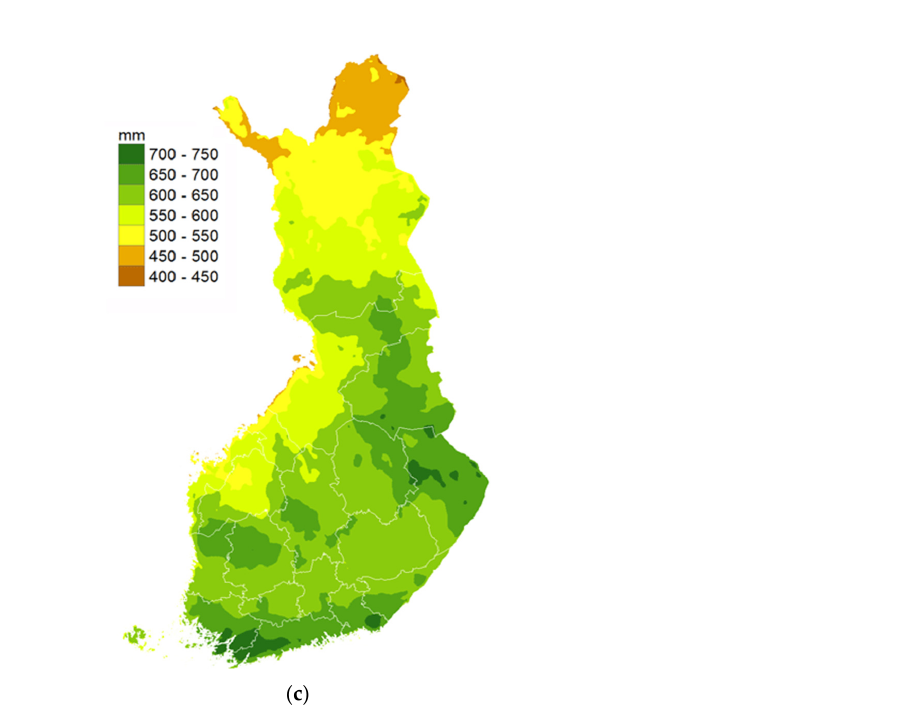
Figure 1. ( a ) Study area and FMI rain-gauge stations, ( b ) hydrological regions in Finland [52,56]. ( c ). Average annual precipitation in Finland (1981–2010). Courtesy: Finnish Meteorological Institute, with permission.